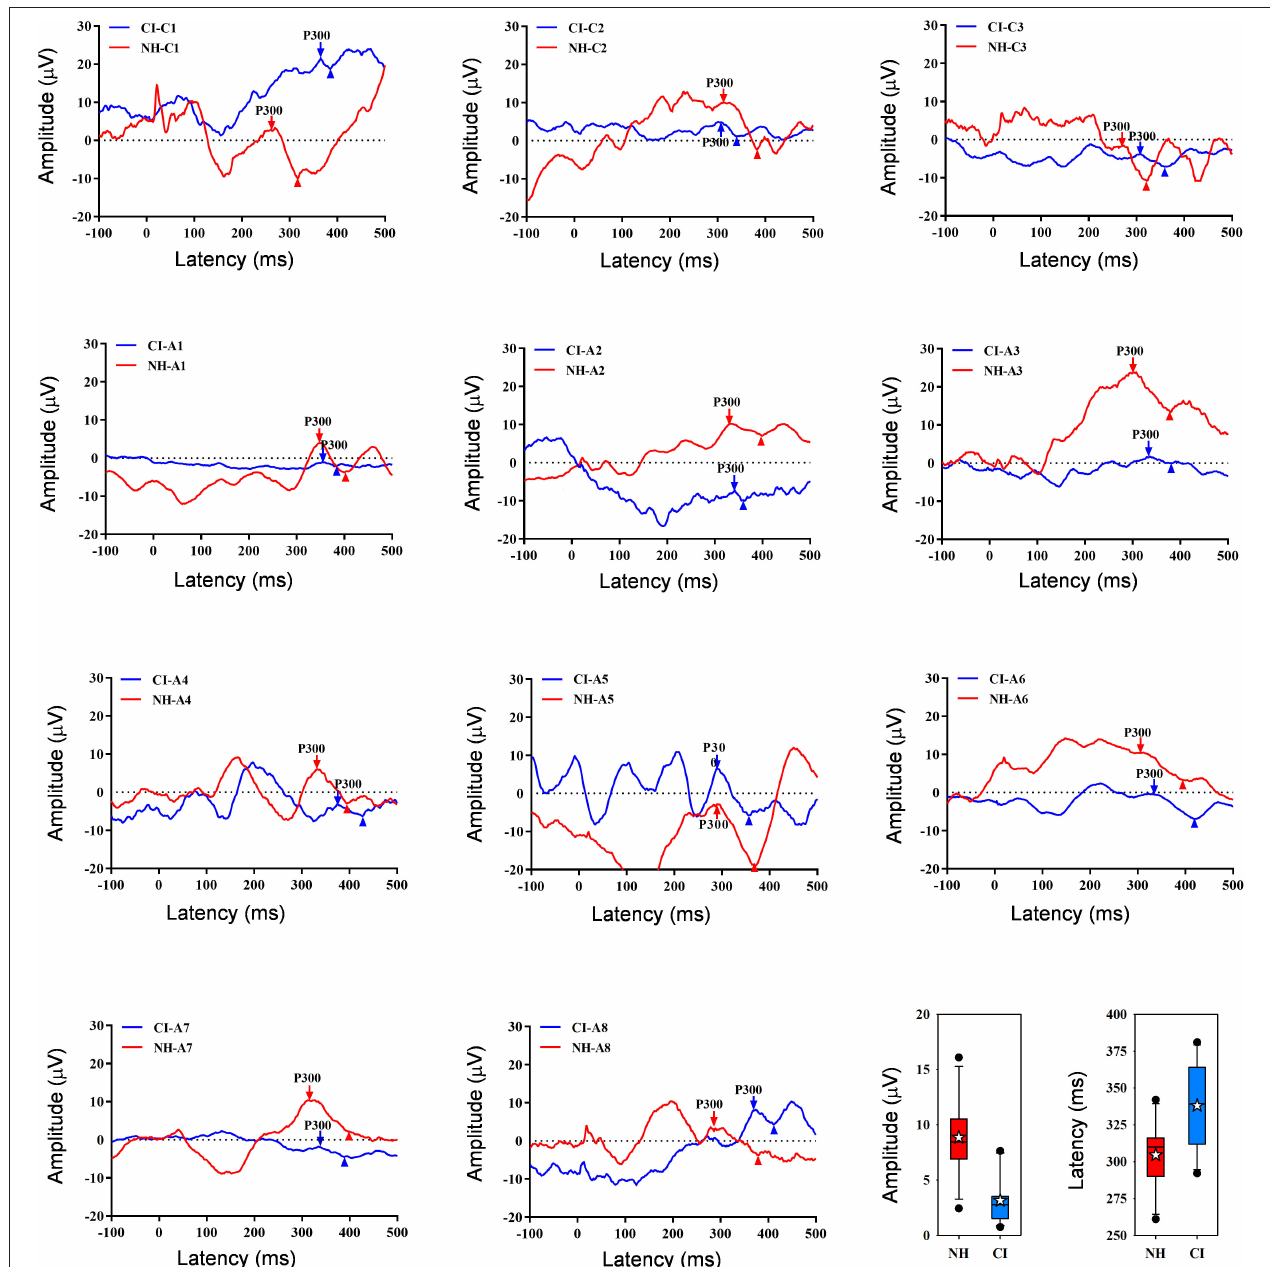
FIGURE 2 | Individual age-matched NH (red) and CI listener (blue) waveforms showing P300 responses averaged across the three test runs. The downward arrows show P300, and the upward triangles show the following negative point; P300 amplitude was calculated between P300 and the negative point. Panels are ordered in terms of age at testing; the top row shows data for child (“C”) participants and the next two rows show data for adult (“A”) participants. The panels at bottom right show boxplots of P300 amplitude and latency across all three runs for NH (red) and CI listeners (blue); the boxes show the 25th and 75th percentiles, the error bars show the 10th and 90th percentiles, the filled circles show outliers, the horizontal lines show the median, and the white stars show the mean.